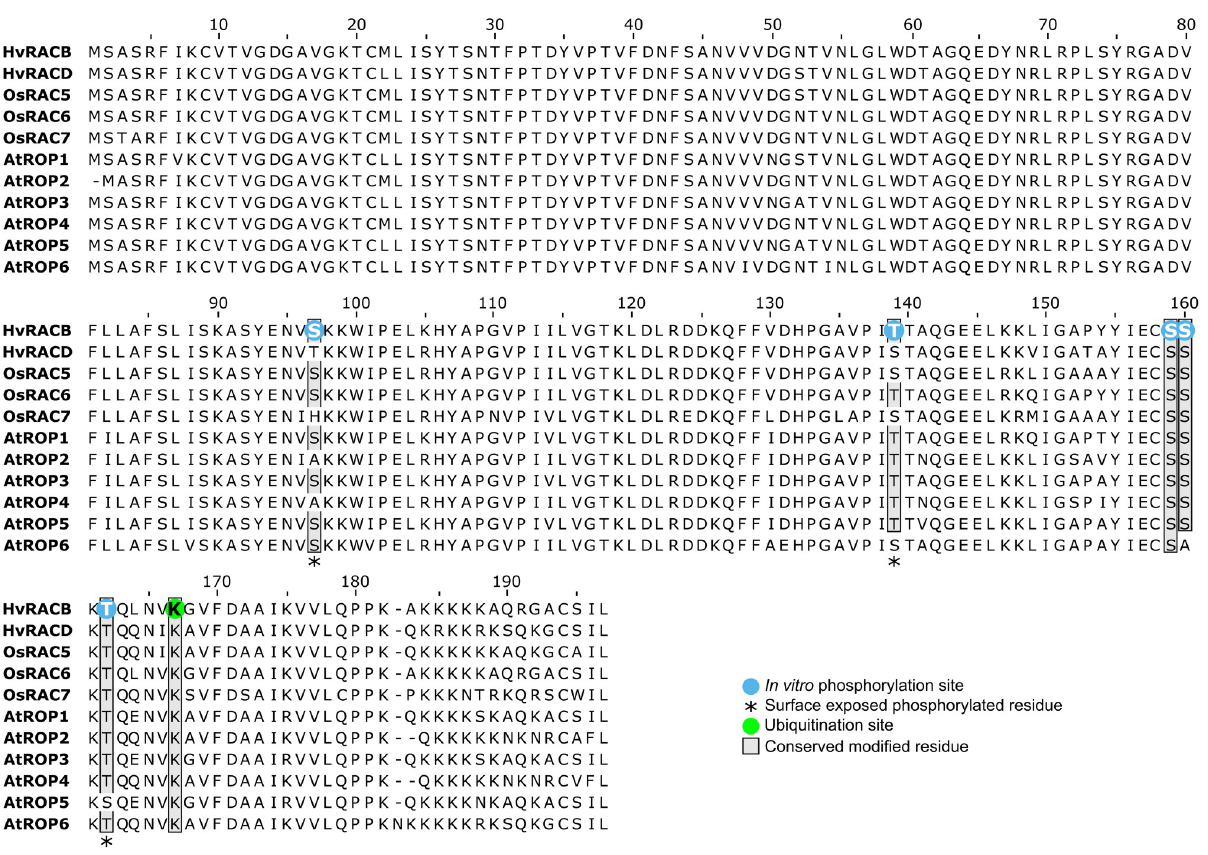
Fig 5. Alignment of type I ROPs from barley ( Hordeum vulgare , Hv ), rice ( Oryza sativa , Os ) and Arabidopsis thaliana ( At ). The ubiquitinated lysine residue in barley RACB (K167, green) is conserved across all type I ROPs from the three species (shaded box). In vitro phosphosites of RACB (blue) are conserved among some type I ROPs (shaded box). Surface-exposed phosphosites are highlighted with asterisks.